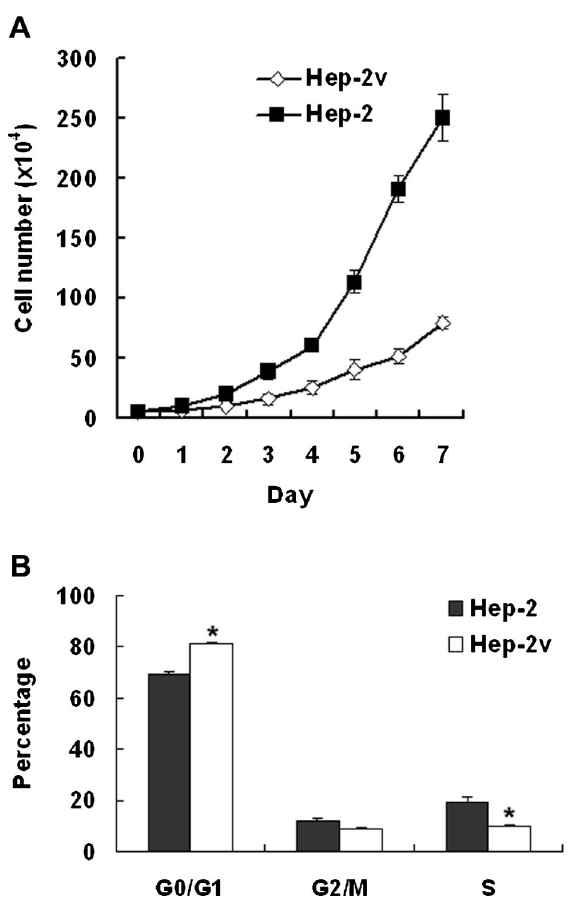
Figure 1. Hep-2/v cells grow slower and have a higher percentage arrest in G0/G1 phase compared to Hep-2 cells. A , Growth curves of Hep-2 and Hep-2/v cells. The data shown represent average values for triplicate cultures and are reported as means±SD. B , Cell cycle distribution of Hep-2 and Hep-2/v cells. Hep-2 or Hep-2/v cells were stained with propidium iodide and analyzed by flow cytometry. Data are reported as mean±SD percentages of cells in different phases. *P , 0.05 vs Hep-2 cells (chi-square